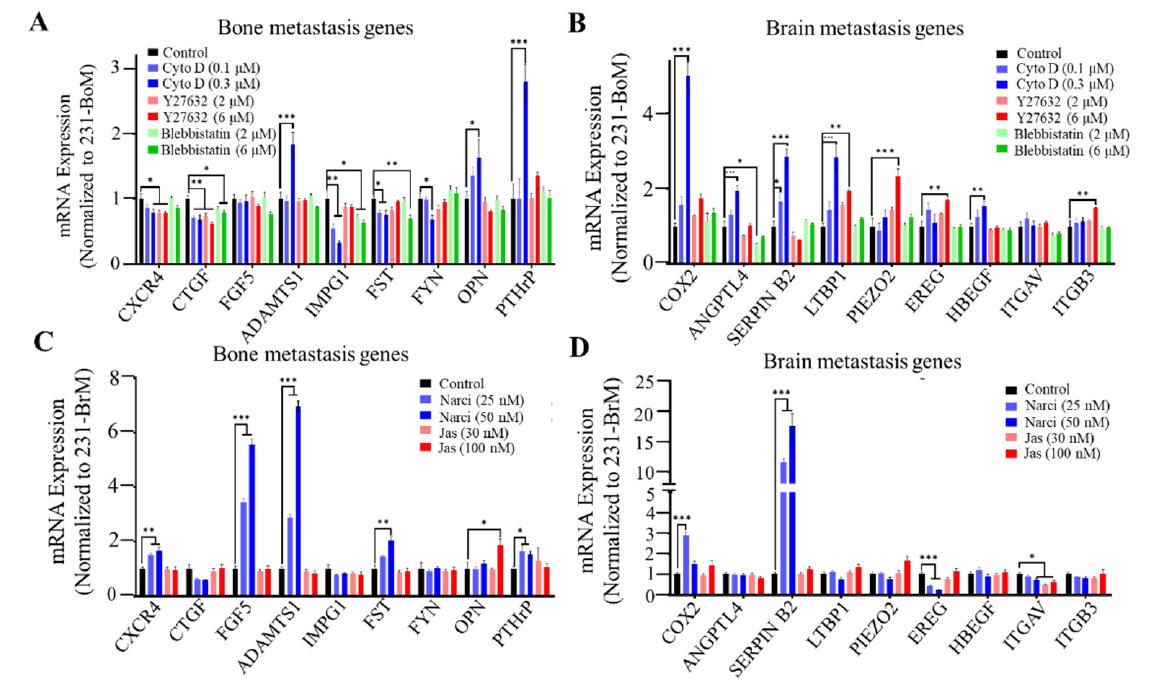
Figure 2. Cell cytoskeleton influences the expressions of bone/brain metastasis-related genes. (A, B) The effect of disrupting cell cytoskeleton on bone/brain metastasis-related genes in 231-BoM cells. The cytoskeleton of 231-BoM cells was disrupted by different dosages of Cyto D, Y27632, and Blebbistatin for 24 h. The expressions of bone metastasis-related genes (CXCR4, CTGF, FGF5, ADAMTS1, IMPG1, FST, FYN, OPN, and PTHrP) ( A ) and brain metastasis-related genes (COX2, ANGPTL4, Serpin B2, LTBP1, PIEZO2, EREG, HBEGF, ITGAV, and ITGB3) ( B ) were measured by quantitative RT-PCR. (C, D) The effect of stabilizing cell cytoskeleton on bone/brain metastasis-related genes in 231-BrM cells. The cytoskeleton of 231-BrM cells was stabilized by different dosages of Narci and Jas for 24 h. The expressions of bone metastasis-related genes (CXCR4, CTGF, FGF5, ADAMTS1, IMPG1, FST, FYN, OPN, and PTHrP) ( C ) and brain metastasis-related genes (COX2, ANGPTL4, Serpin B2, LTBP1, PIEZO2, EREG, HBEGF, ITGAV, and ITGB3) ( D ) were measured by quantitative RT-PCR. n= three independent experiments. The data represent mean ± SEM. * p < 0.05; ** p < 0.01; and *** p <